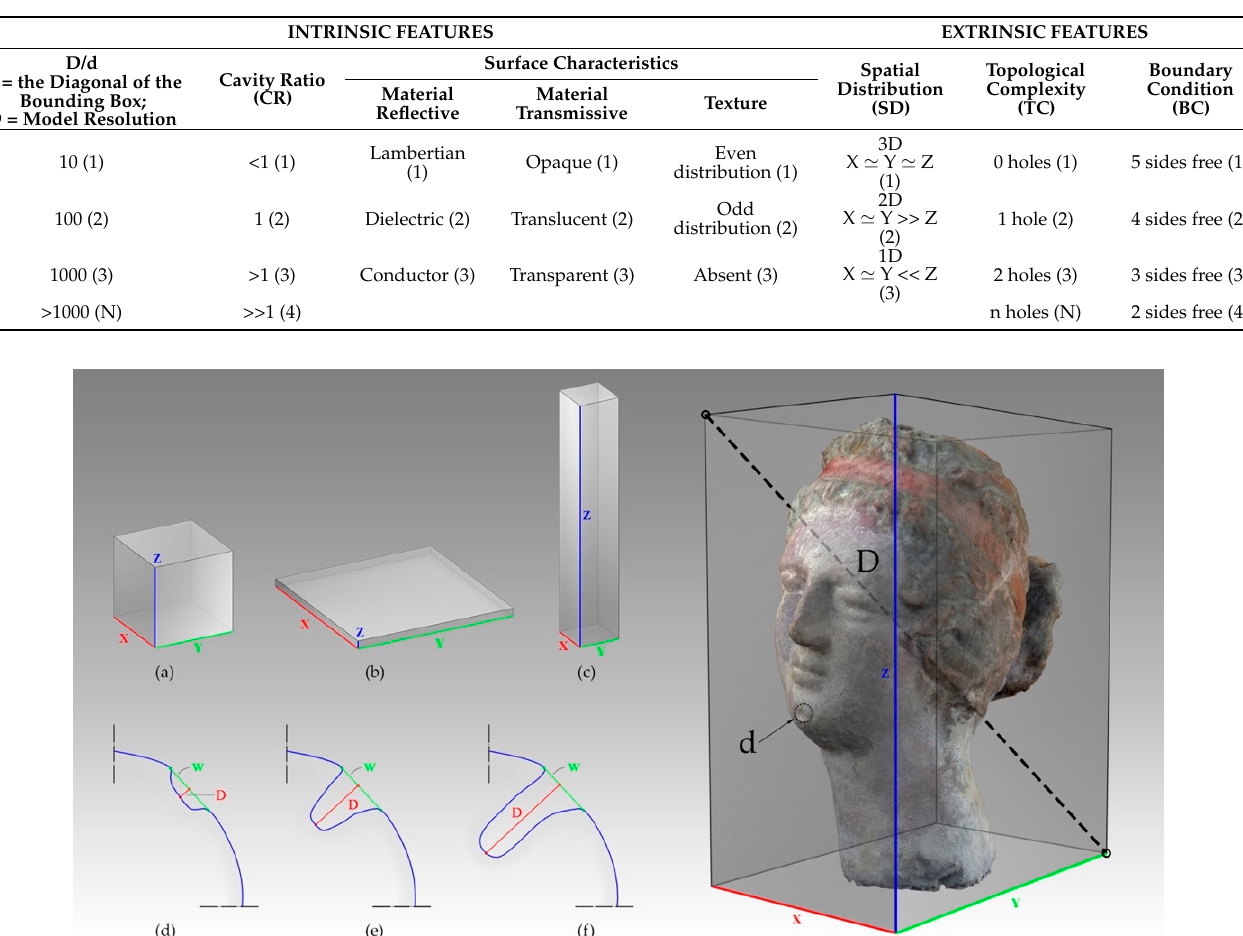
Figure 7. Extrinsic features : Spatial distribution (SD) ( a – c ); Intrinsic features : Cavity ratio (CR) ( d – f ); D/d ratio (right).